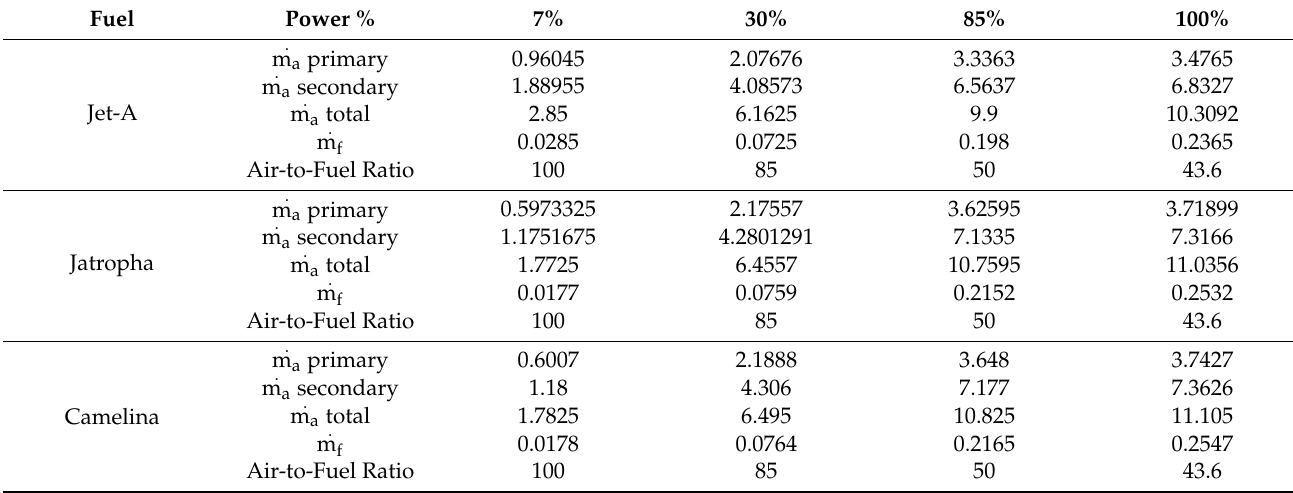
Table 6. Boundary conditions